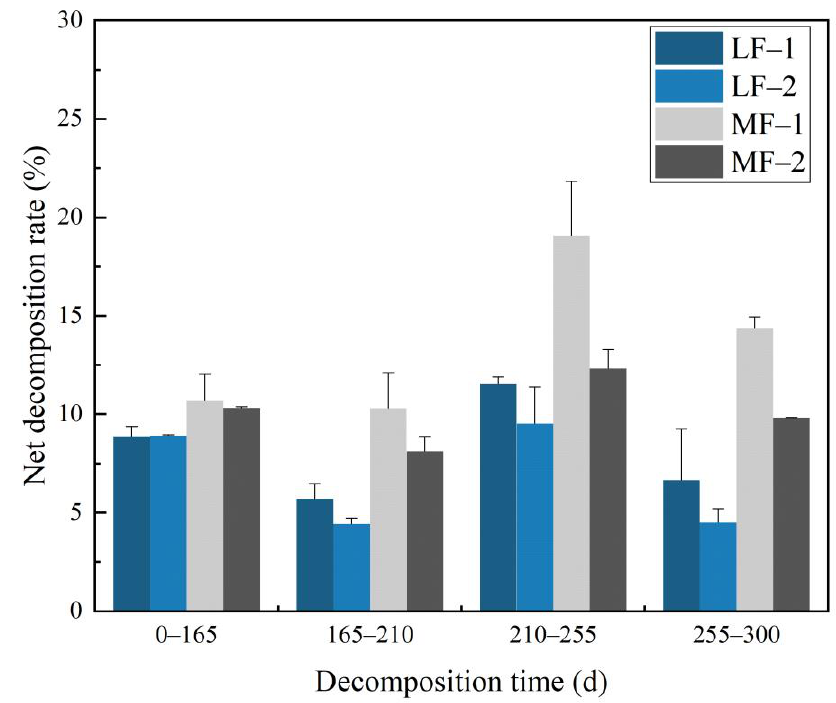
Figure 6. Dynamic changes in the net decomposition rate of litter. MF–1: Mixed Larix principis- rupprechtii and Betula platyphylla forest, 4 mm litterbags; MF–2: Mixed Larix principis-rupprechtii and Betula platyphylla forest, 0.01 mm litterbags; LF–1: Larix principis-rupprechtii forest, 4 mm litterbags; LF–2: Larix principis-rupprechtii forest, 0.01 mm litterbags.